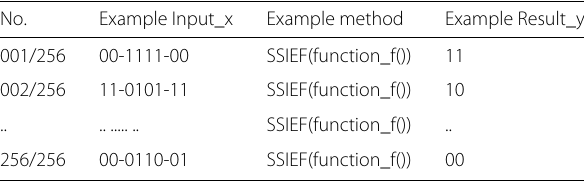
Table 6 Brute-force querying the algorithm by re-using the